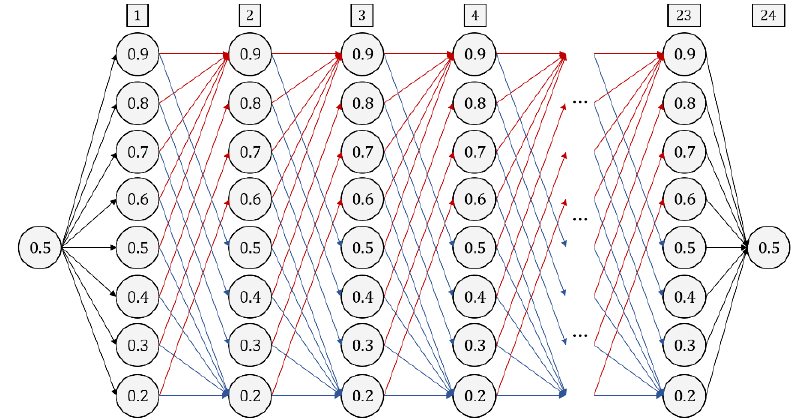
Figure 6. Conceptual diagram of status and stage definitions for SOC of ESS.